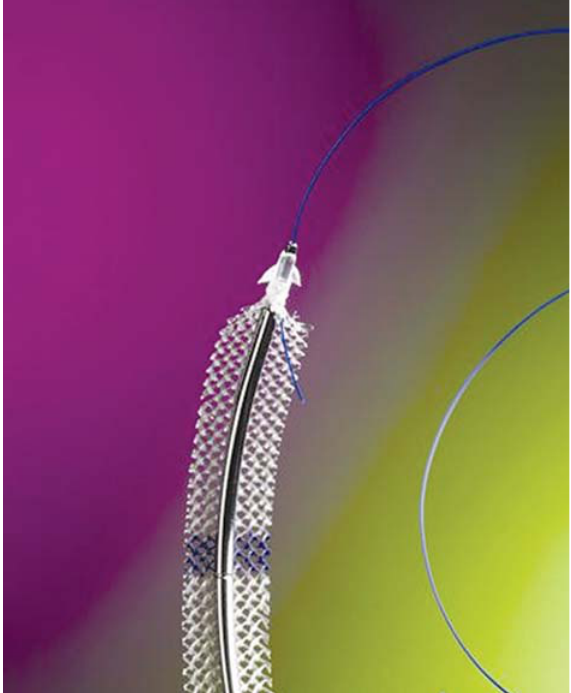
Figure 2 – The needle kit